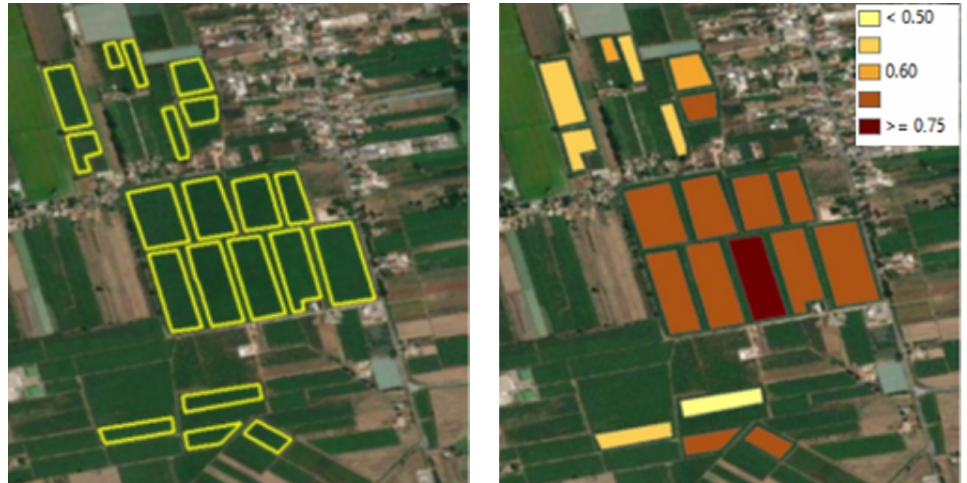
Figure 10. Results of the application of the trained NN on kiwi fields in Italy. The legend shows the probability of a field infection (in this case, representing similar behavior as those fields validated in other regions of interest).